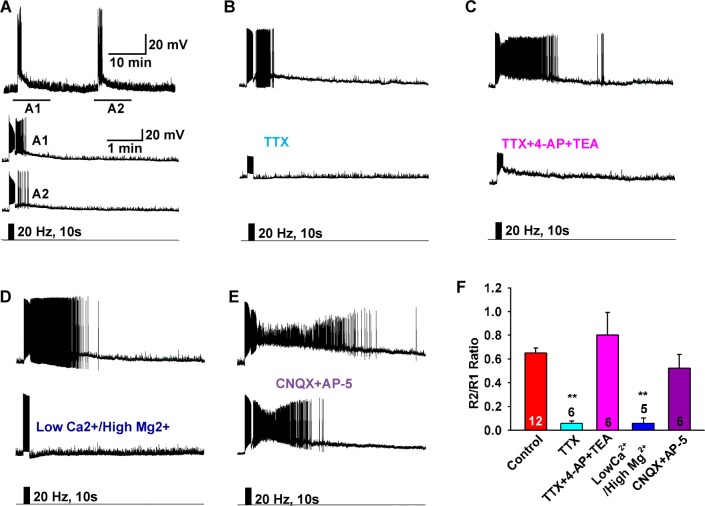
Slow EPSP is dependent on direct synaptic input from neighboring Kiss1 neurons.(A) To reduce the variability between Kiss1 neurons from different animals, a response ratio (R2/R1) protocol was used in which the magnitude of second light response (A2) was compared to first response (A1). Representative traces showing that the R2/R1 ratio of two photostimuli is 0.65 in Kiss1ARH neurons. (B–E), Representative traces showing that the slow EPSP was abolished by perfusing TTX (B), and the TTX blockade was rescued by the addition of the K+ channel blockers 4-AP and TEA, suggesting a direct synaptic input from other Kiss1 neurons (C); the slow EPSP was abolished by perfusing low Ca2+/high Mg2+ (D); and the slow EPSP was unaffected by the ionotropic glutamate receptor antagonists CNQX and AP5 (E). (F) Bar graphs summarizing the effects of drugs on the direct synaptic input (EPSP) to Kiss1 neurons. Comparisons between different treatments were performed using a one-way ANOVA analysis (F (4, 30) = 12.18, p<0.0001) with the Newman-Keuls’s post hoc test. ** indicates p<0.01 vs. control.